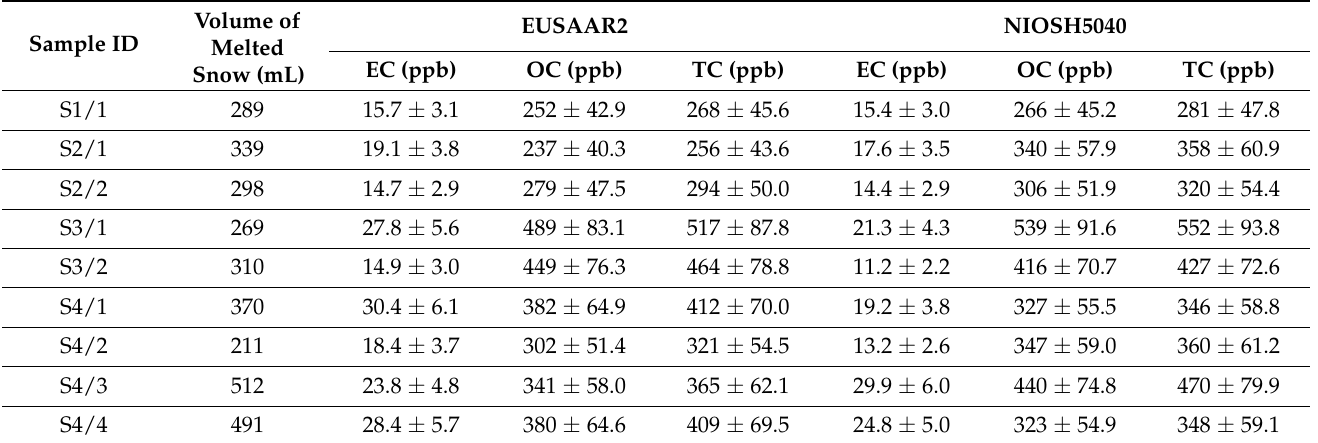
Table 2. Results of the snow samples analyzed at TU Wien using the EUSAAR2 and NIOSH5040 protocols. Uncertainty of 20% added to EC results and 17% uncertainty added to OC and TC